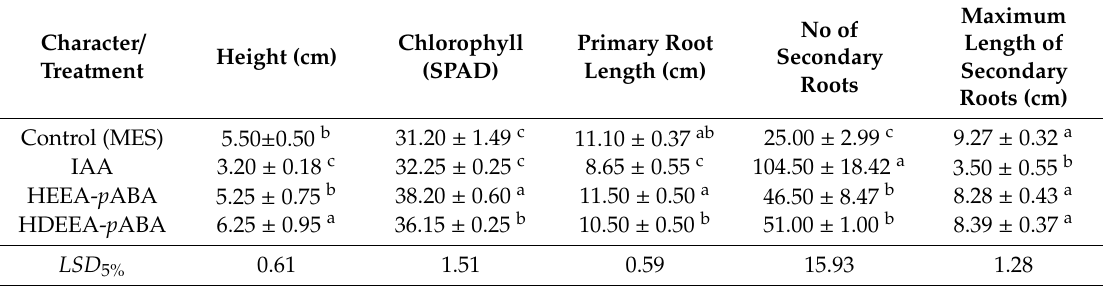
Table 4. The influence of treatments on tomato seedlings (cv. Tomtim).